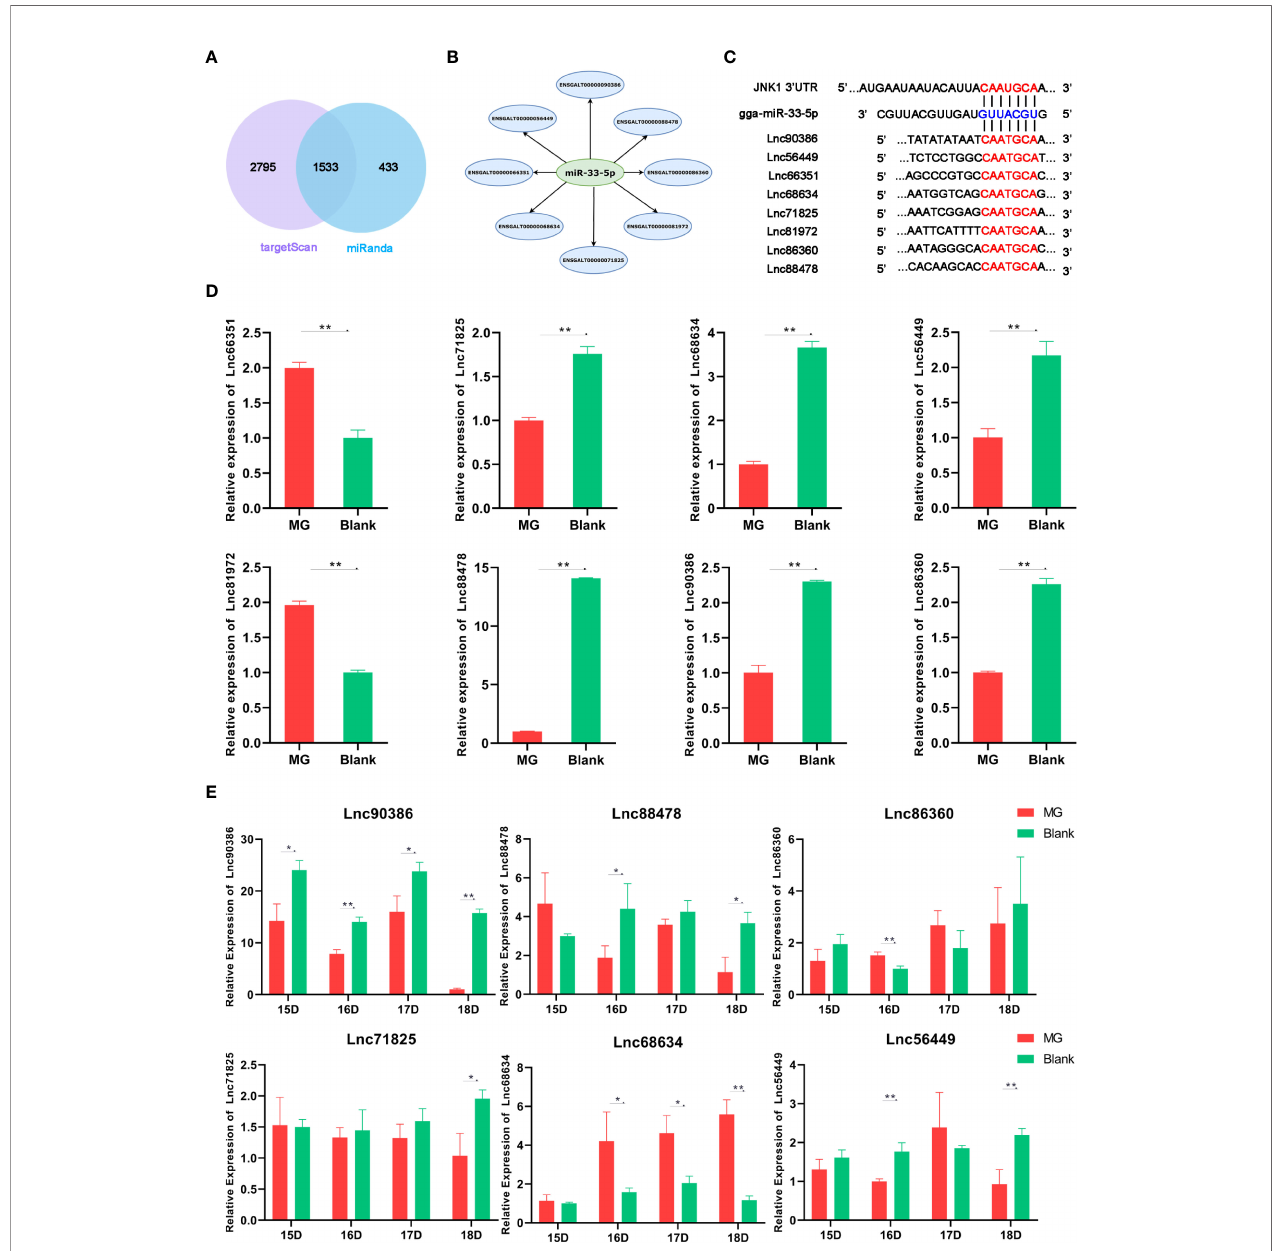
FIGURE 7 | Relative lncRNA expression level in cells and chicken embryonic lung tissue. (A) A venn diagram depicting 1533 lncRNAs that were predicted to target miR-33-5p both by TargetScan and miRanda; (B) Candidate LncRNAs; (C) Bioinformatic database showing bindings sites of both JNK1 3 ’ UTR and 8 lncRNAs to miR-33-5p; (D) DF-1 cells and CP-II cells were cultured in a 6-wells plate and treated MG. After 24h infection, we isolated the total RNA from infected cells via TRNzol Universal and detected the lncRNA expression by RT-qPCR; (E) On the 9th day of the chicken embryo hatching, MG was injected into the allantoic fl uid,